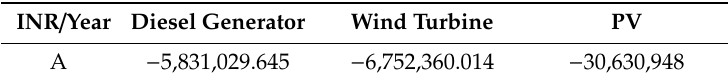
Table 2. Annual repayment.